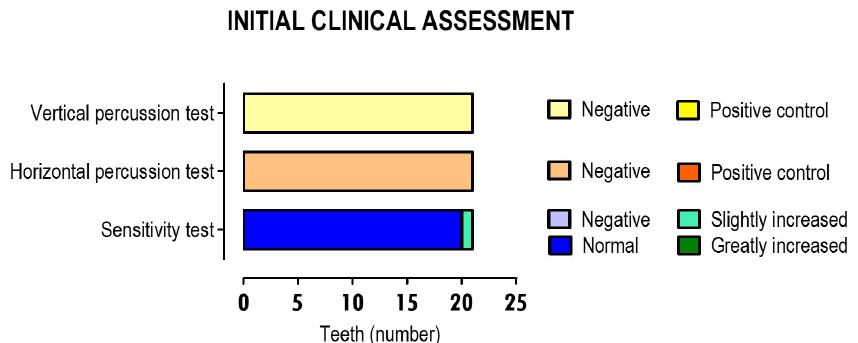
Figure 4. Pre-therapeutic clinical assessment, assessment of changes in cold and horizontal and vertical percussion sensitivity tests. The results correspond to 21 teeth in which pulp capping therapies were performed.